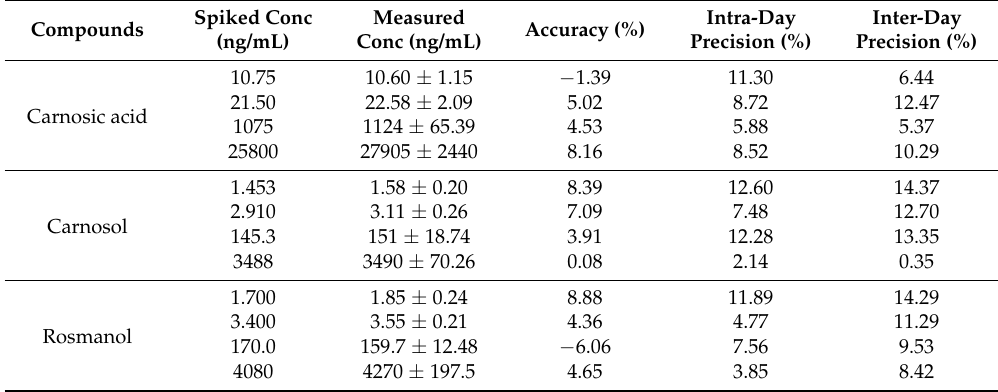
Table 3. Intra-day and inter-day precisions and accuracies for the determination of the three diterpenes from the assay samples. Spiked Conc Measured Compounds (ng/mL) Conc (ng/mL)